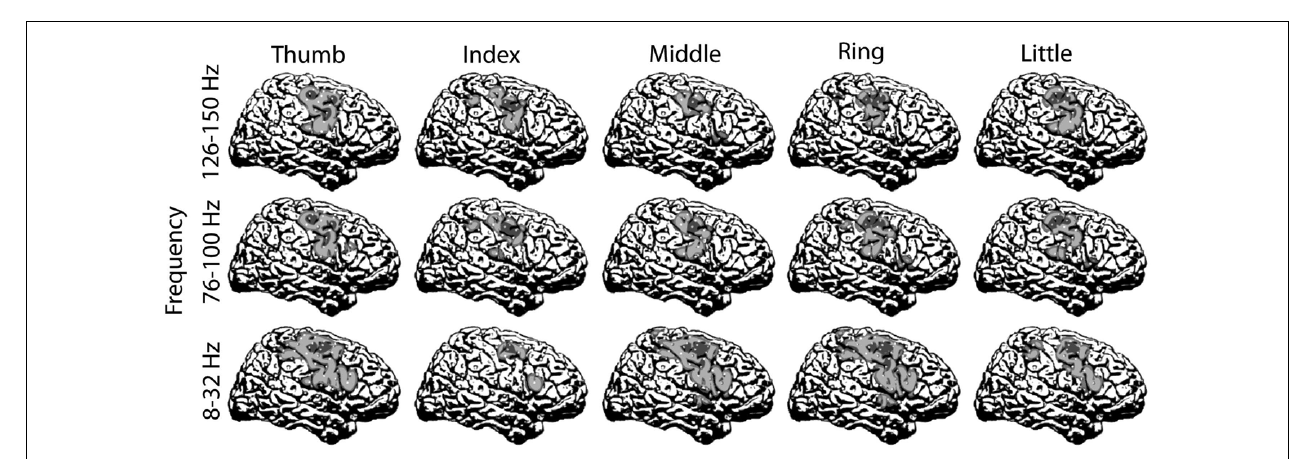
spatially much more broad, corresponding to fluctuations in the classic motor rhythms. Figure 29 shows that the spatial representations for high frequencies are very different for different finger movement types, within a general hand region. Electrode positions are shown with white dots, and power change with light and dark gray patches on the brain